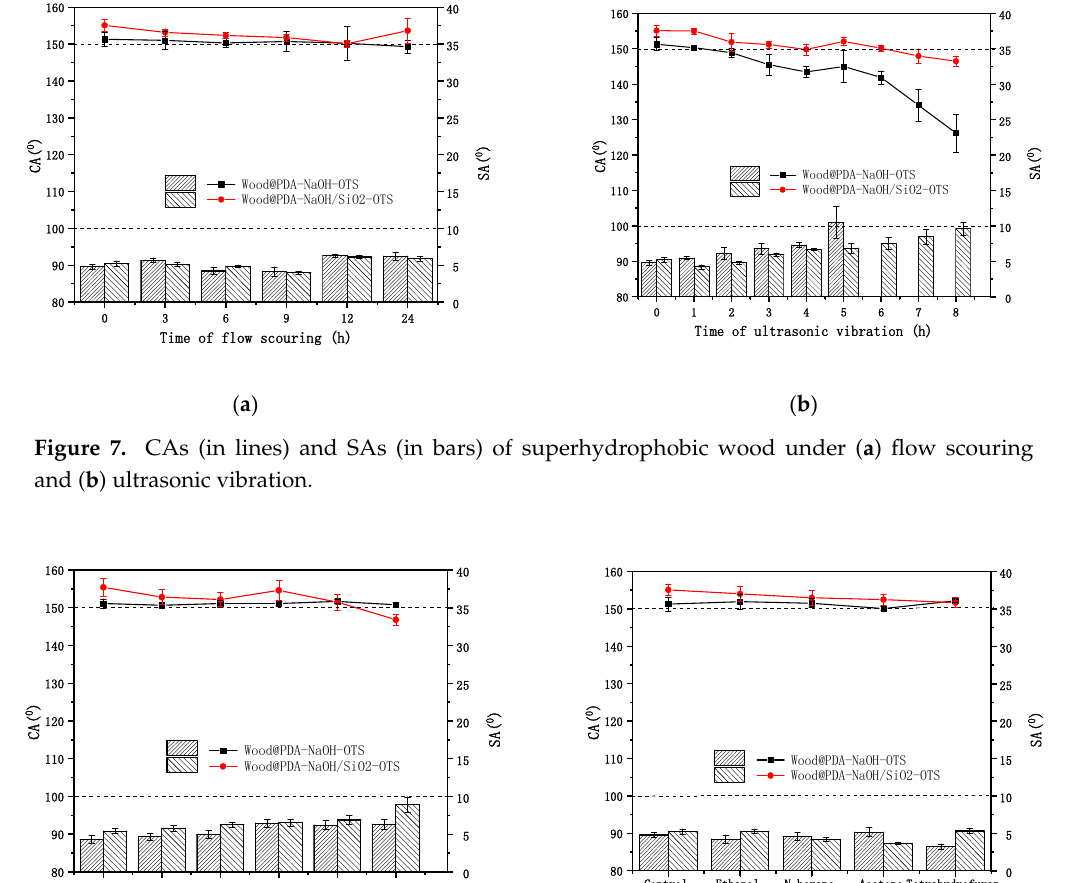
Figure 7. CAs (in lines) and SAs (in bars) of superhydrophobic wood under ( a ) flow scouring and ( b ) ultrasonic vibration.